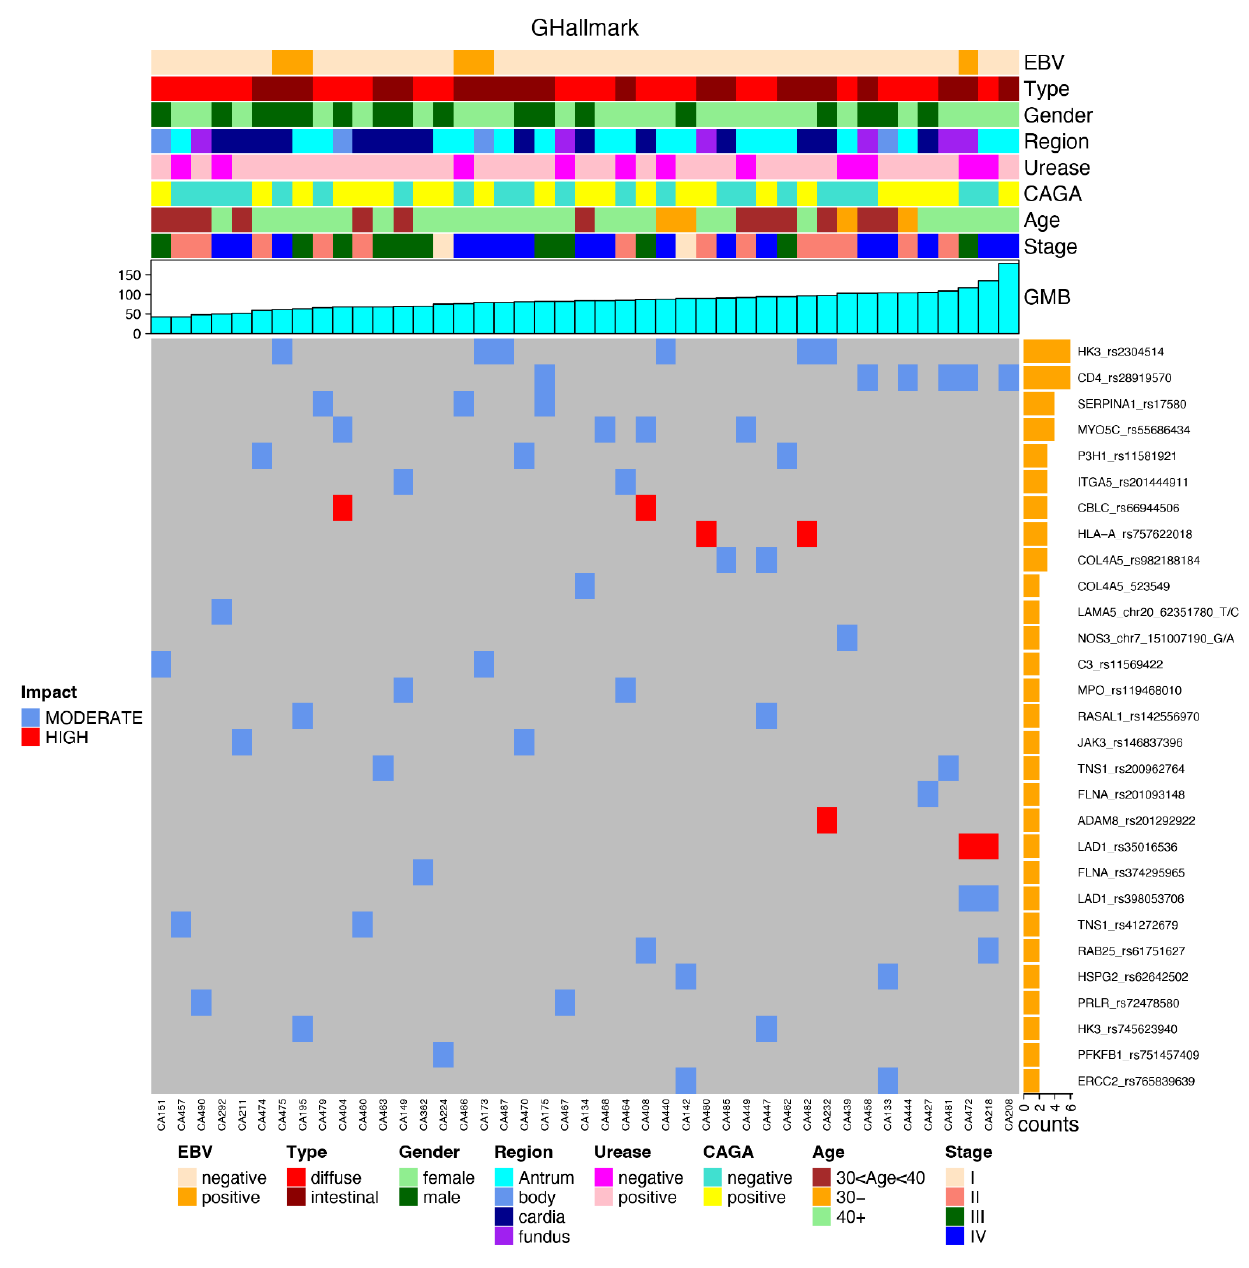
Figure 7. Correlation of most prevalent variants in the GHallmark gene’s subset among young pa- tients with gastric cancer and their distribution according to clinical features (EBV status, histological type, gender, region of the stomach, urease status, CAGA status, age group and stage), GMB and mutation impact (moderate or high).